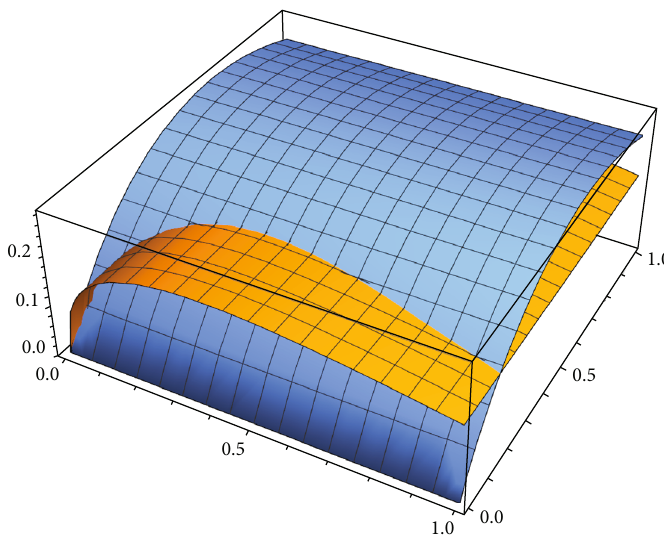
Figure 1: Simulations of the solution for α = 0 : 5 and α = 0 : 9 :